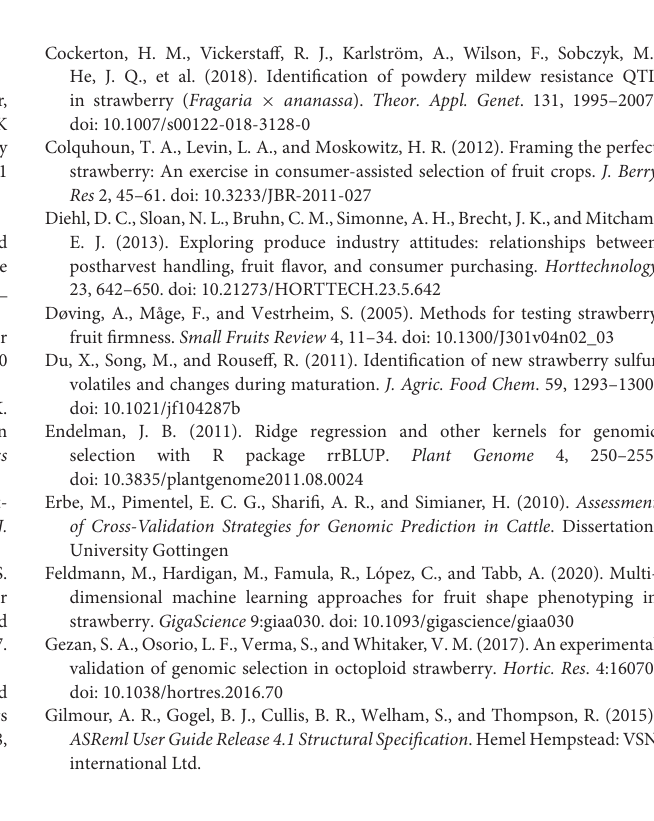
Supplementary Table 2 | Visual, textural and organoleptic trait category descriptors of strawberries. Texture type and shape were assessed as discrete ordinal categorical traits and provide context for Texture Rating and Height: Width measures respectively. Texture Type and Shape were not assessed for genetic components. Supplementary Table 3 | Upper and lower bounds of broad-sense heritability (H2) and narrow-sense heritability (h2) for strawberry fruit quality and yield traits across the multi-parental population. Model denotes the BLUEs model fitted per trait where the term DV represents the date of picking and visual recorder specified as random effects, DO represents the date of picking and organoleptic recorder specified as random effects. Variation in date superseded variation in the block. B represents block specified as a random effect D represents the date of picking specified as a random effect. All prediction models were weighted by replicate number. The impact of block, picking date and genome by environment interactions (G × E) on traits; significance values are ANOVA tests comparing mixed models. p values are denoted by stars: ∗∗∗ < 0.001, ∗∗ < 0.01, ∗ < 0.05, < 0.01 NS - not significant. Importance denotes the importance of breeding on a scale from 1 (not important) to 9 (highly important). The number of quantitative trait nucleotides (QTN) identified through GWAS after Bonferroni correction. The coefficient of determination (R2) indicates the proportion of variation explained by the combined QTN. Supplementary Table 4 | Mean and SEs for fruit quality traits. Values were provided for each of the blocks studied. NT - Not tested due to plant protection products prohibiting the consumption of fruit. Supplementary Table 5 | QTN associated with strawberry yield and fruit quality traits identified through a GWAS. Bold marker names were associated with multiple traits. Supplementary Table 6 | Mean, SE for fruit yield traits. Values were provided for each of the families studied. Malling Centenary has been abbreviated to